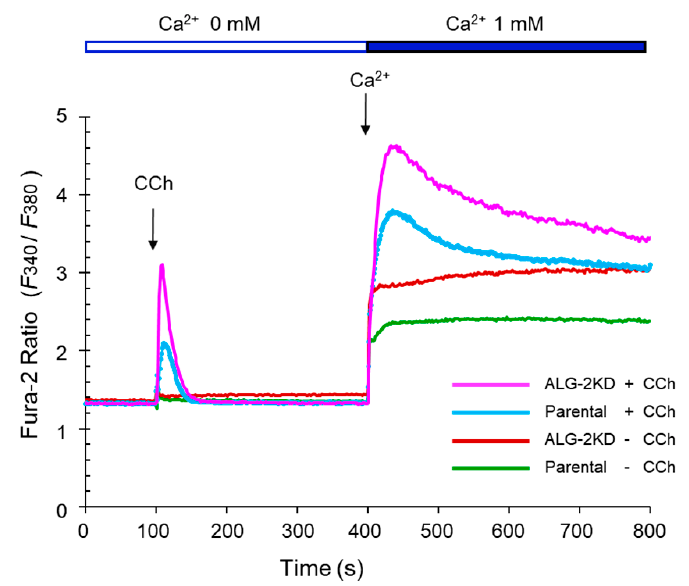
Figure 7. Augmented Ca 2+ mobilization in the ALG-2KD cells detected by Fura-2 fluorescence ratiometry. The parental HEK293 and ALG-2KD cells were loaded with Fura-2 AM, and ratiometric analysis using a spectrofluorometer was performed as described in Materials and Methods. Ratio of 510 nm-fluorescence intensity ( F 340 / F 380 ) by alternate excitation at 340 and 380 nm was recorded. Cells suspended in a Ca 2+ -free Ringer ’ s solution containing 0.01 mM EGTA were stimulated with carbachol (+CCh, 100 μ M) or mock treated ( − CCh) at 100 s, followed by addition of Ca 2+ to the cell suspension (final concentration, 1 mM) at 400 s to initiate Ca 2+ entry from the extracellular space.